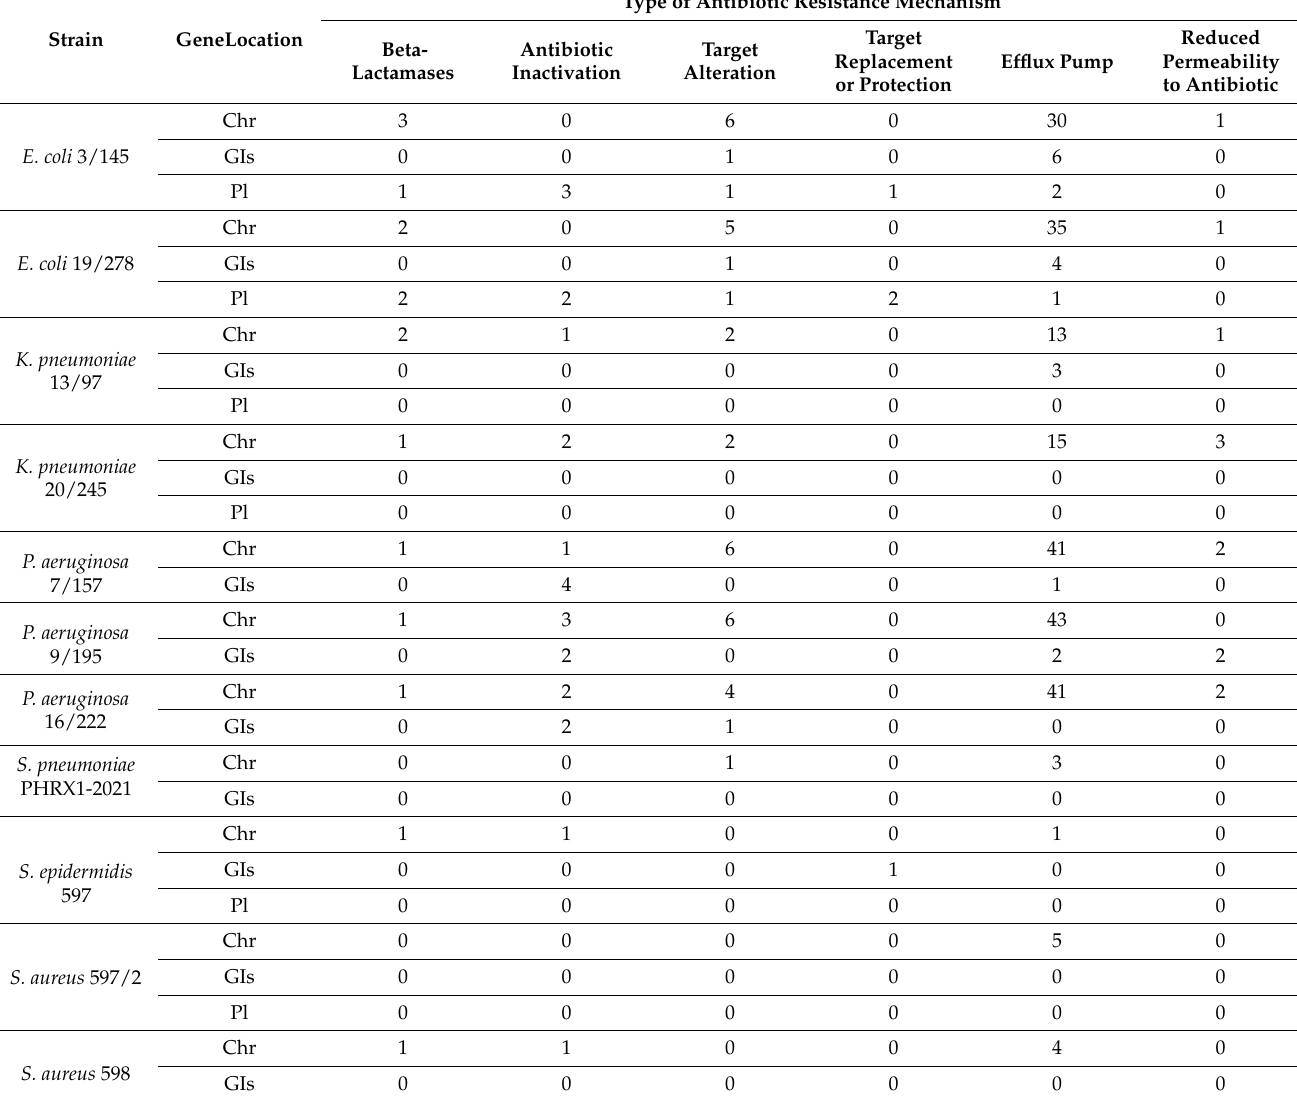
Table 3. Numbers of antibiotic resistance genes of different categories detected in the studied genomes on the core parts of the chromosomes (Chrs), identified genomic islands (GIs) and on the plasmids